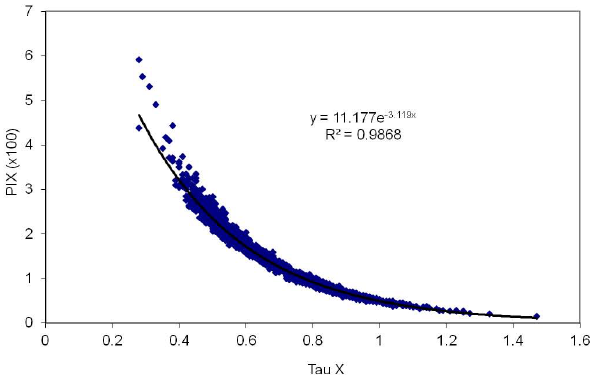
Fig. 5. PI X , derived from the AMSR-E measurements, as a func- tion of the optical depth estimated by using the Nelder–Mead inver- sion method. The obtained regression is: PI X = 11 . 18 exp ( − 3.12 τ) ( R 2 = 0 . 99).